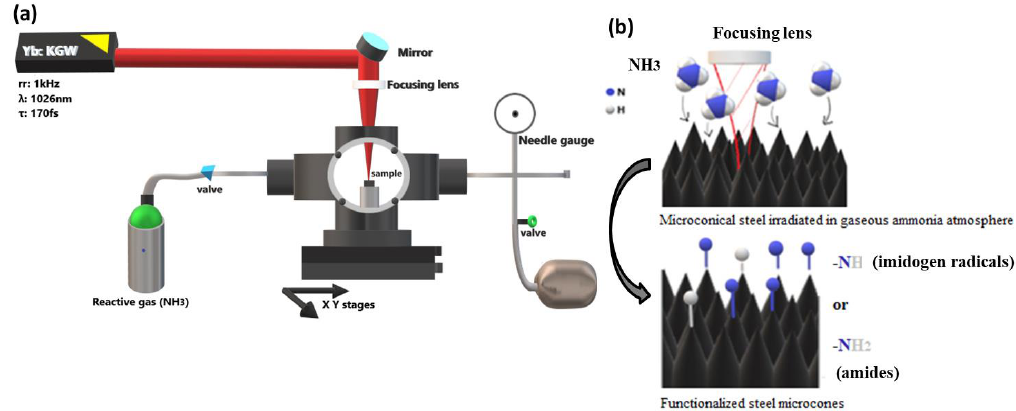
Figure 1. ( a ) Schematic of the experimental ultrashort laser setup used in this study. Experimental procedure of the fabrication of the functionalized micro / nanopatterned steel substrates using ammonia gaseous atmosphere during the irradiation procedure; ( b ) Schematic of micropatterned substrates during and after ultrashort pulsed laser processing under gaseous ammonia atmosphere.